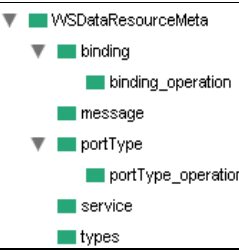
Figure 1. The hierarchical semantic properties representation of WSDL